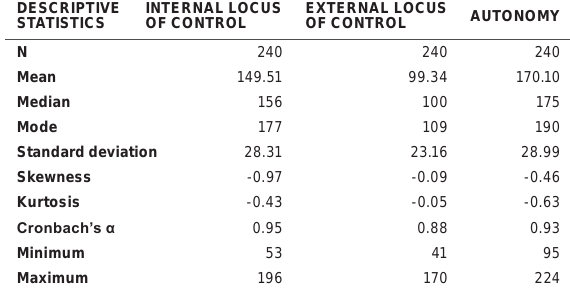
TABLE 6 Descriptive statistics for Internal Locus of Control, External Locus of Control and Autonomy as measured by the Locus of Control Inventory DEscripTivE sTATisTics